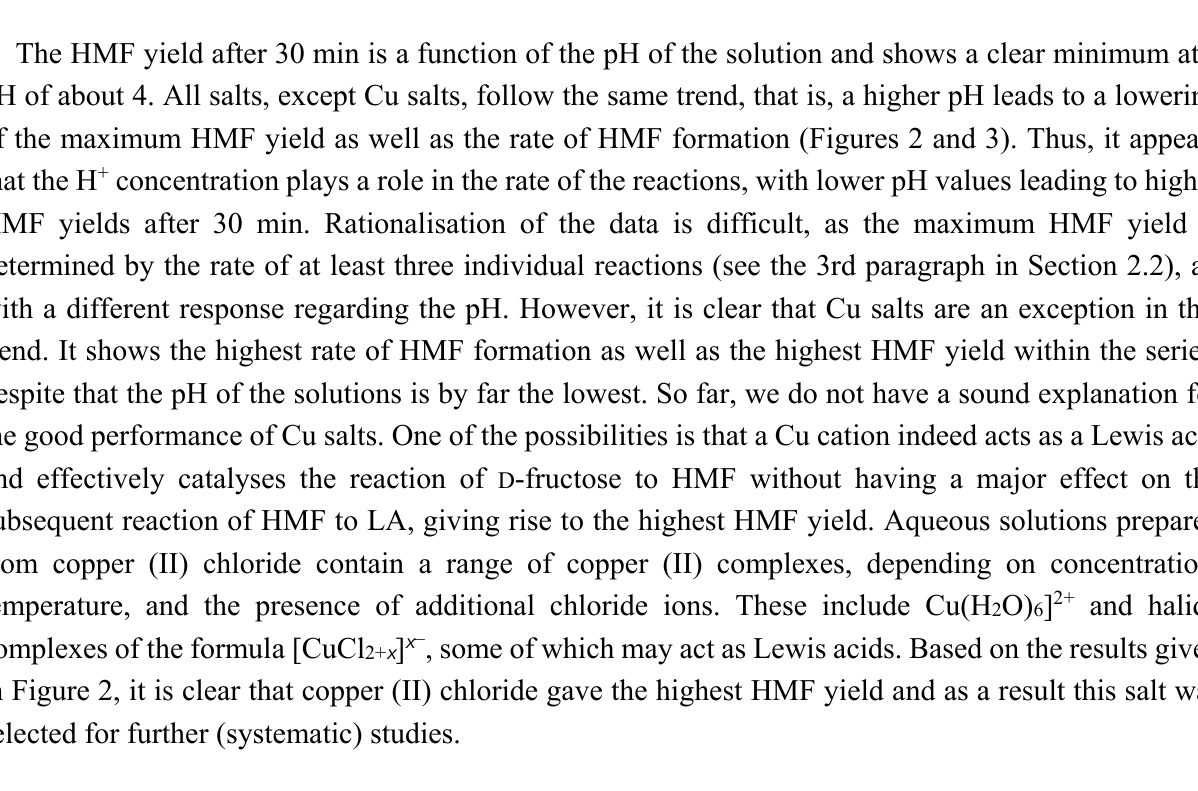
Figure 3. HMF yield versus the pH of the solution of the various metal salts in water (170 °C, inulin intake of 0.1 g/mL, 5 mM salt, 30